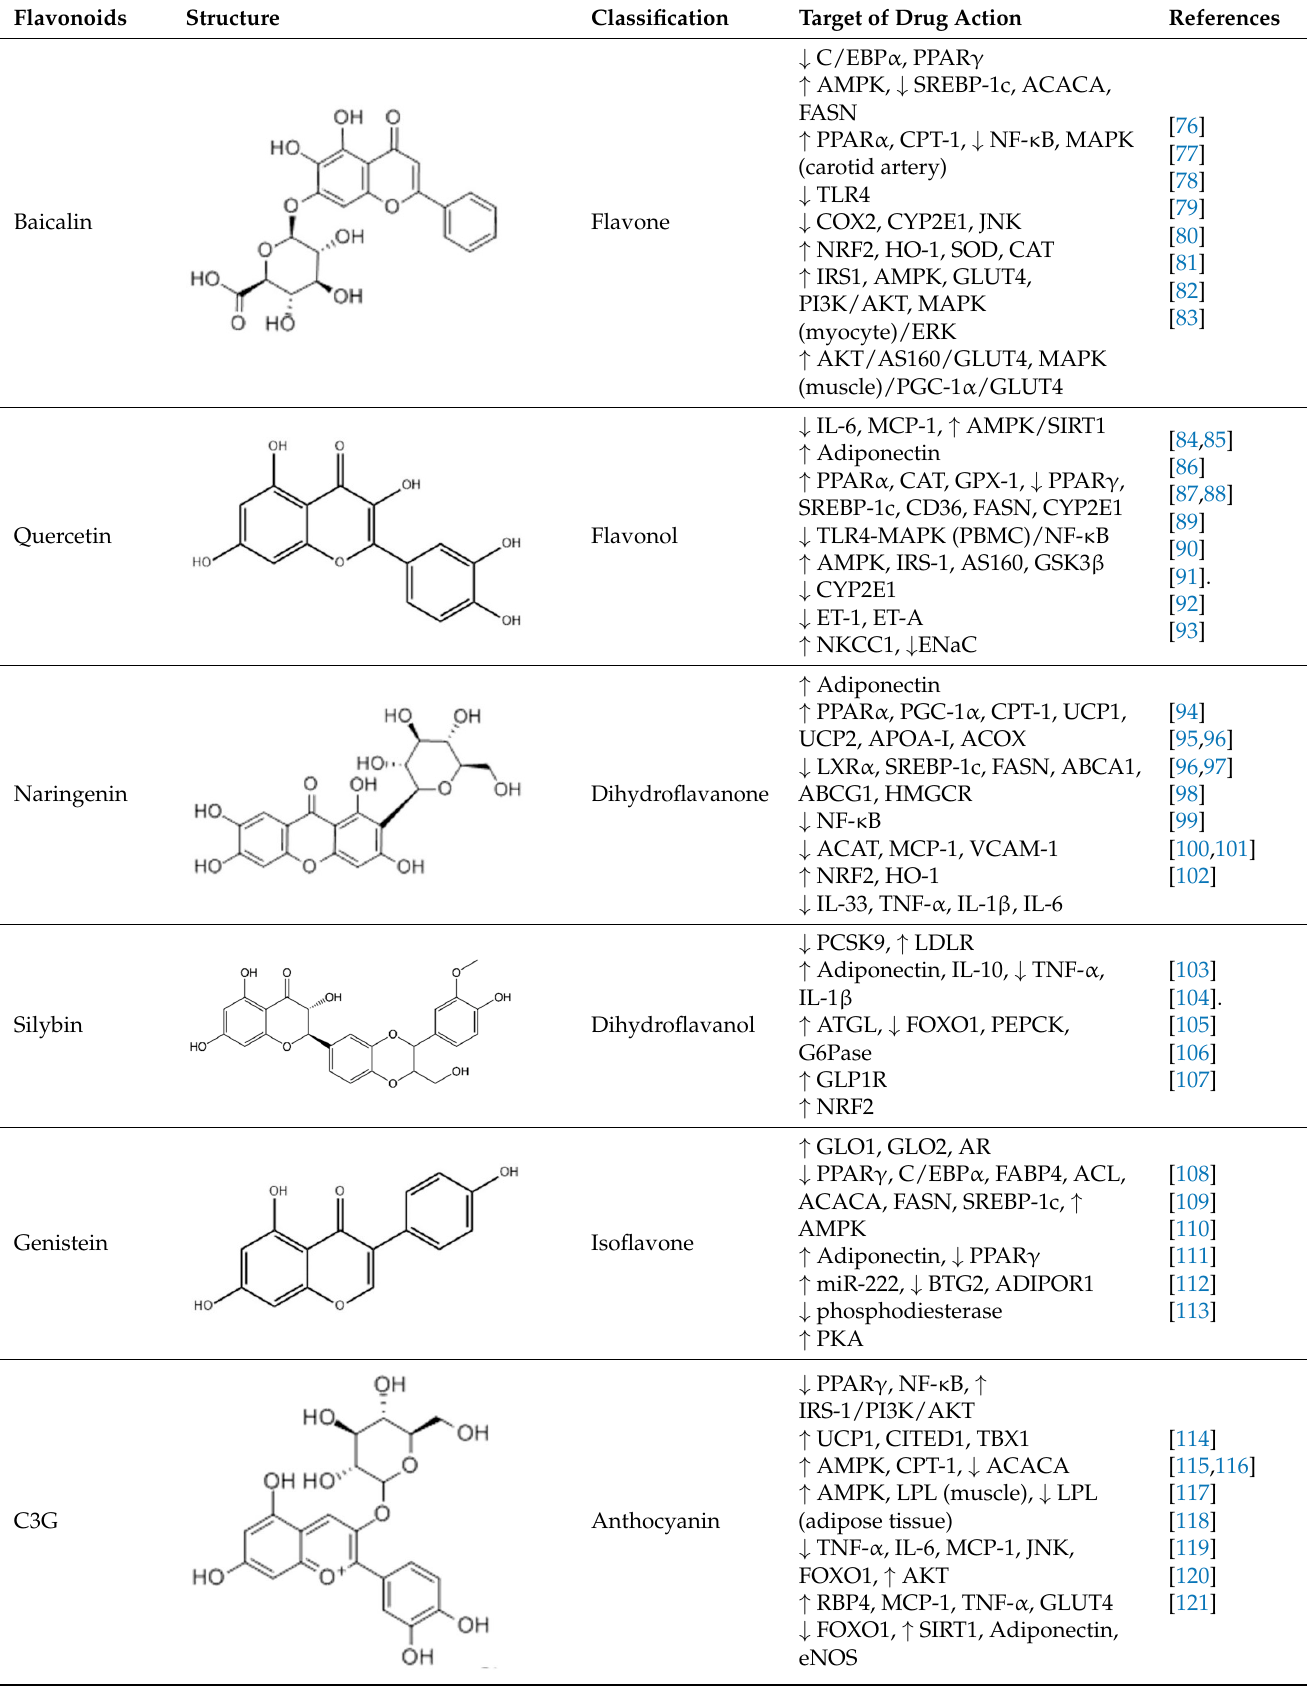
Table 2. Structure and classification of representative flavonoids and their mechanisms of action targeting MetS.